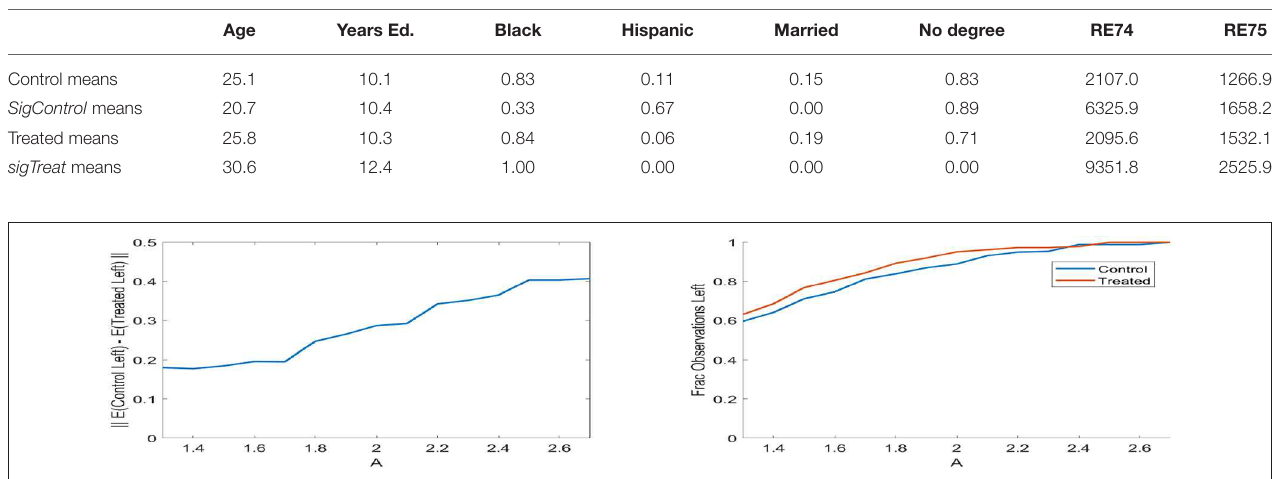
TABLE 2 | Mean value of each feature for the control group and treated group as a whole, and for the subsets of the groups that are deemed to be definitively within one class.